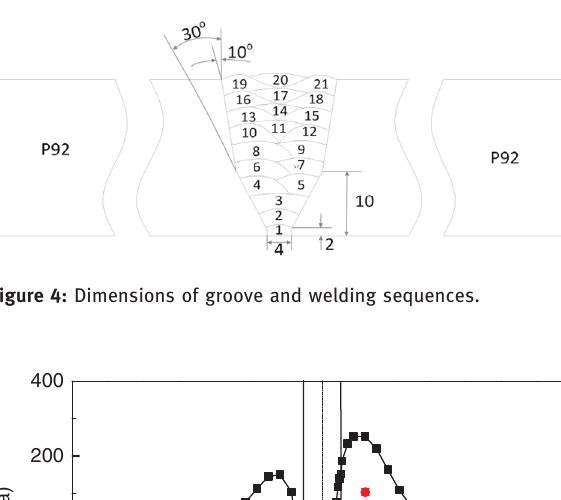
Figure 3: Finite element meshes.